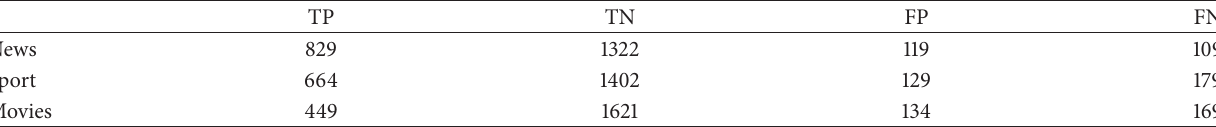
Figure 1: ROC curve for news, sport, and movie, respectively. Table 1: Number of positive and negative occurrences for each